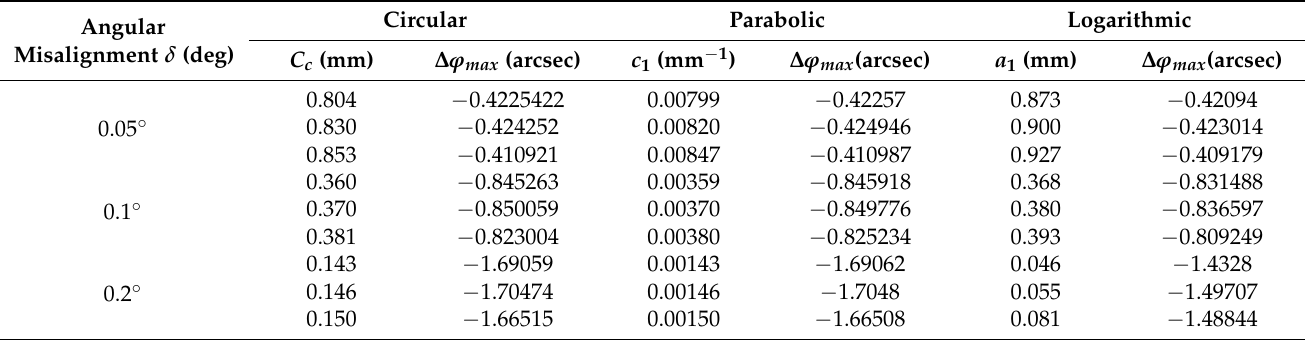
Table 6. Amount of modifications relative to out-of-plane angular misalignment for helical gears engagement.